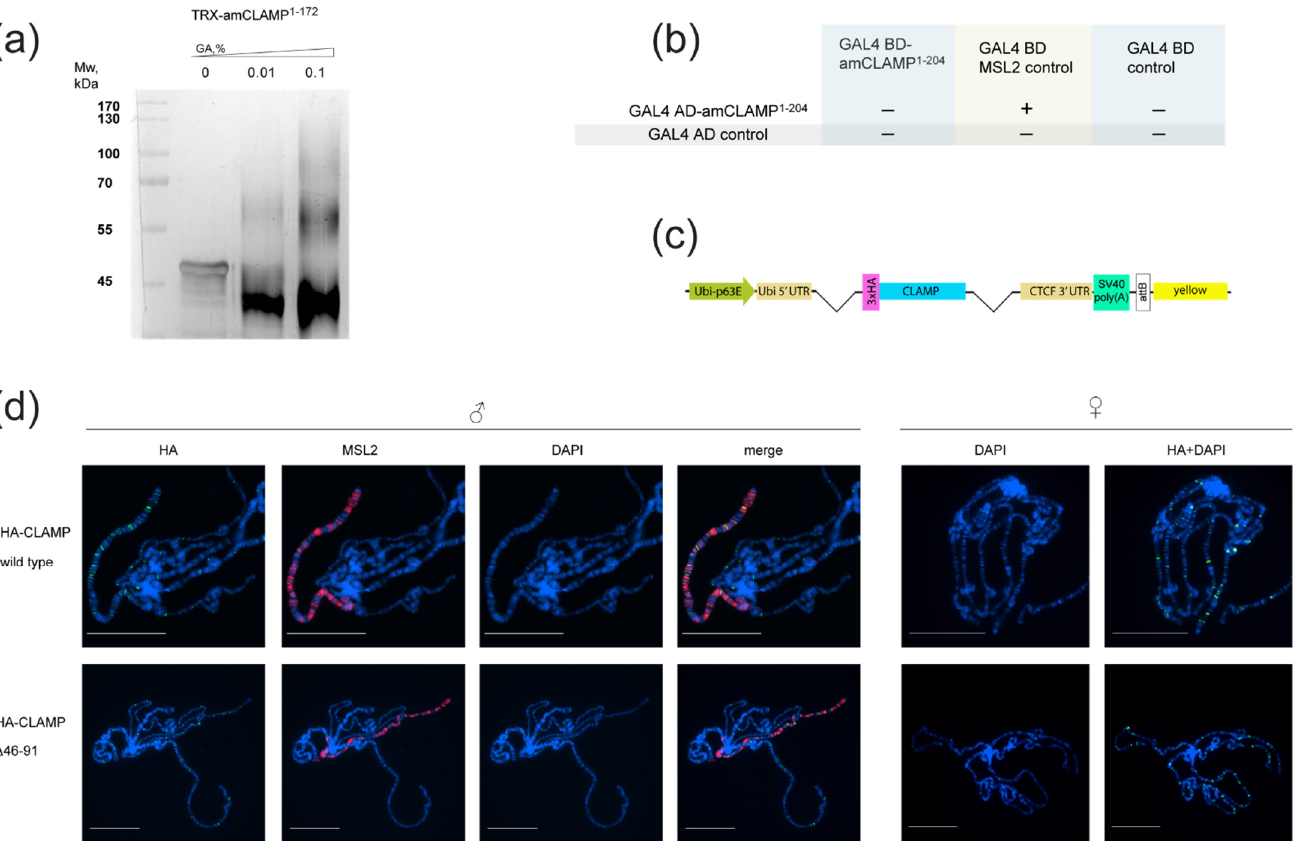
Figure 4. ( a ) Cross-linking of thioredoxin-tagged amCLAMP 1–172 using increasing concentrations of glutaraldehyde (GA). ( b ) Testing of the dimerization activity of amCLAMP 1–204 using a yeast two-hybrid assay. AD stands for GAL4 activation domain and BD stands for GAL4 DNA-binding domain. Positive interaction indicates the ability of yeast to grow on assay plates without histidine. Assay plates are shown in the Figure S2. ( c ) Schematic representation of rescue constructs expressing 3xHA-tagged CLAMP proteins under the control of ubiquitin-p63E promoter; SV40 poly(A)–SV40 polyadenylation signal; attB is the site for φ C31-mediated recombination used for site-specific insertion of the construct; yellow represents the intronless yellow gene used as a reporter. ( d ) Effect of deletion of the dimerization domain in the HA-tagged CLAMP proteins on their recruitment to the chromatin shown by immunostaining of polytene chromosomes with anti-HA and anti-MSL2 antibodies in males and females. Scale bar is 20 μ m.